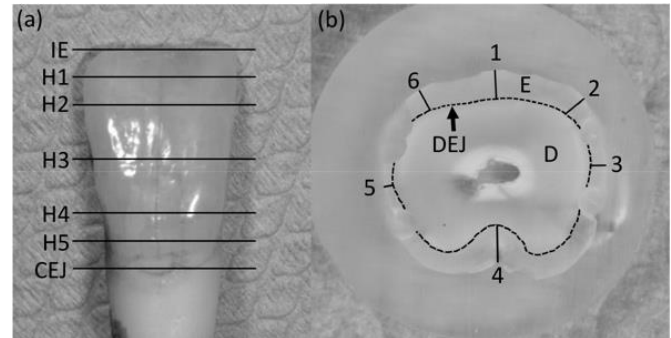
Figure A2. ( a ) Measurement sites; ( b ) A cross section of the measurement sites. The distance from the incisal edge (IE) on the middle of the labial surface in the longitudinal axis of the tooth to CEJ was divided into eight equal parts. From IE, a total of five cross sections comprised 1/8 ( H1 ), 1/4 ( H2 ), 1/2 ( H3 ), 3/4 ( H4 ), and 7/8 ( H5 ). Clockwise from the center of the labial surface, the measurement sites were the middle of the labial surface (1), mesiofacial surface (2), mesial surface (3), lingual surface (4), distal surface (5), and distofacial surface (6). However, the mesial and distal surfaces of H5 were excluded.